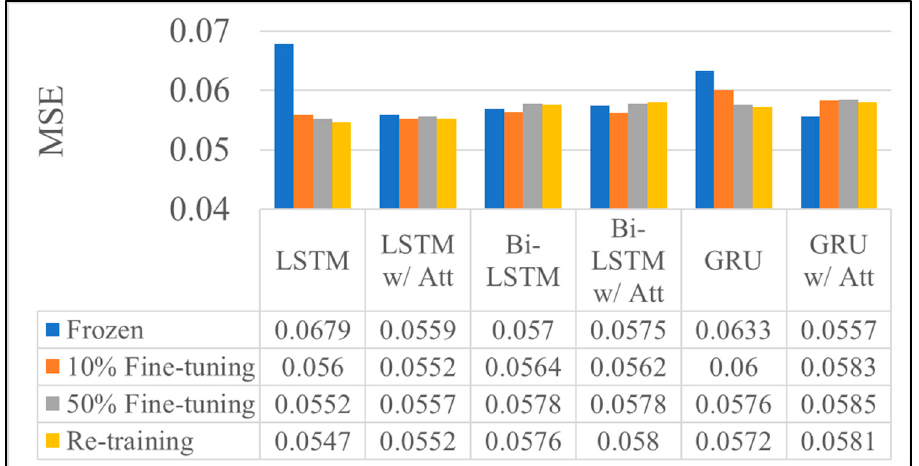
Figure 12. MSE of the target disease course prediction of TL-CDC with attention mechanism under k = 2.